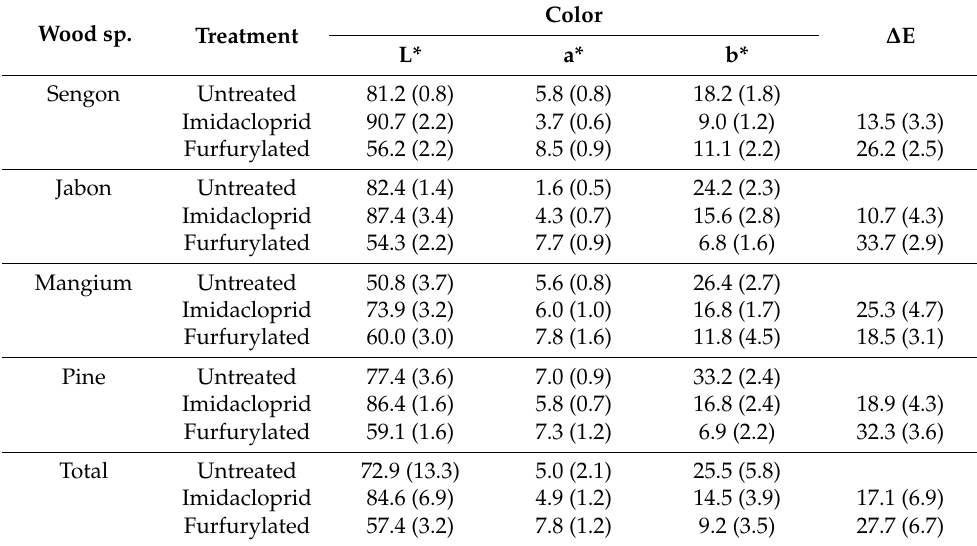
Table 5. The color of untreated and treated wood samples. Wood sp.